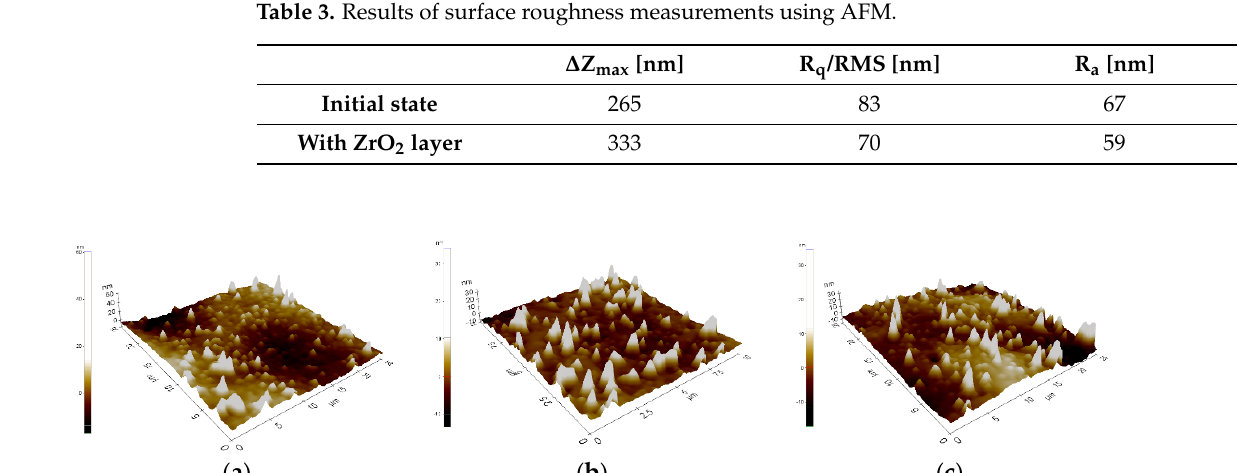
Figure 2. Surface topography of the EOS CoCr RPD alloy with ZrO 2 layer, three-dimensional unevenness diagram, ( a – c )—examples of measure area. Table 3. Results of surface roughness measurements using AFM.